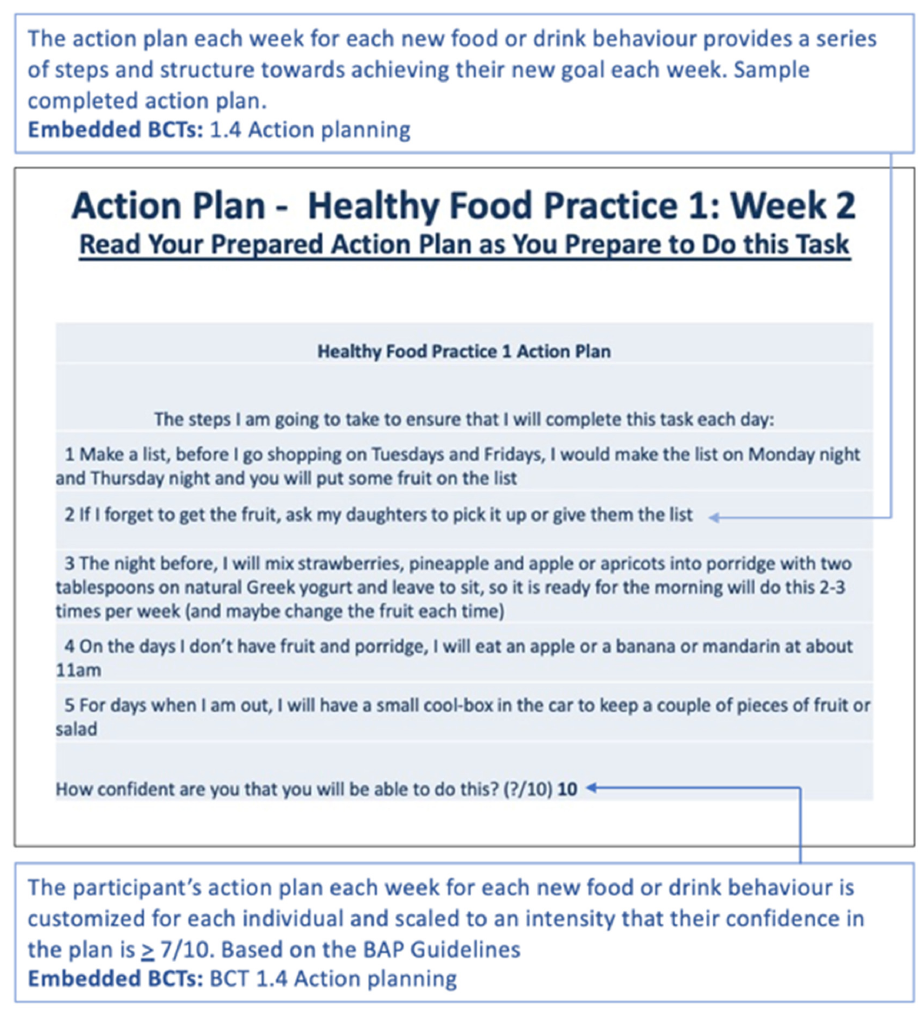
Figure 12. Week 2 developed an action plan for health food practice 1. The text in the blue boxes is explanatory text and not part of the planner. The BCTs used, refer to the Michie et al. taxonomy [17]. The BAP Guidelines, refer to the Gutnick, D. et al. [40].